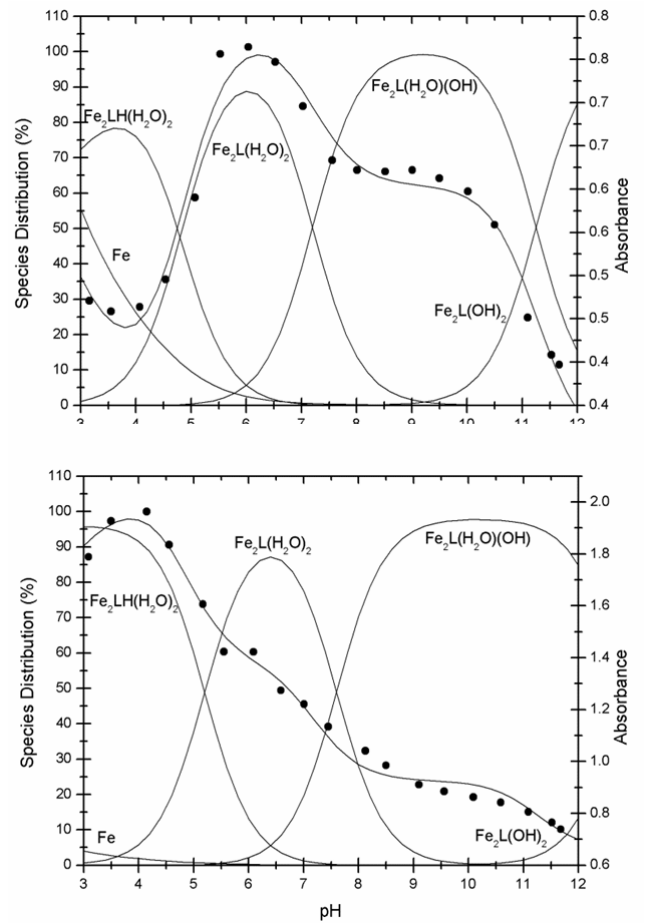
Figure 5. Correlation between the species distribution and the absorption spectra of Fe PC at bottom. (% = Percentage of species distribution in solution). at top and Fe 2